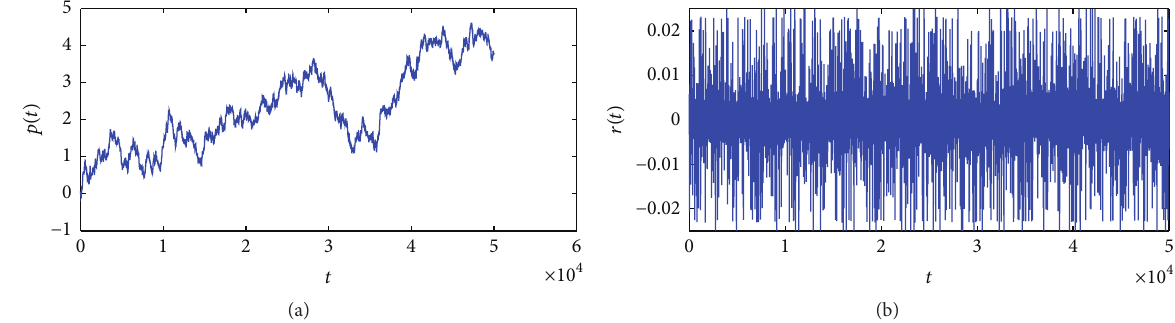
Figure 2: In these figures we show the realization of the logarithm of the price over 5×10 4 time steps (a), and the time series of the log returns of the price (b).